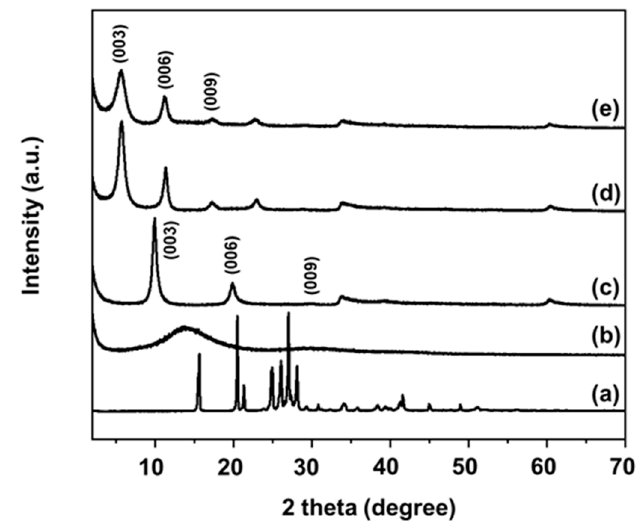
Figure 1. PXRD patterns of (a) intact NA, (b) Eudragit ® S100, (c) pristine LDH, (d) NA-LDH and Figure 1 . PXRD patterns of ( a ) intact NA, ( b ) Eudragit ® S100, ( c ) pristine LDH, ( d ) NA-LDH and ( e ) (e) Eudragit ® S100-coated NA-LDH. Eudragit ® S100-coated NA-LDH.